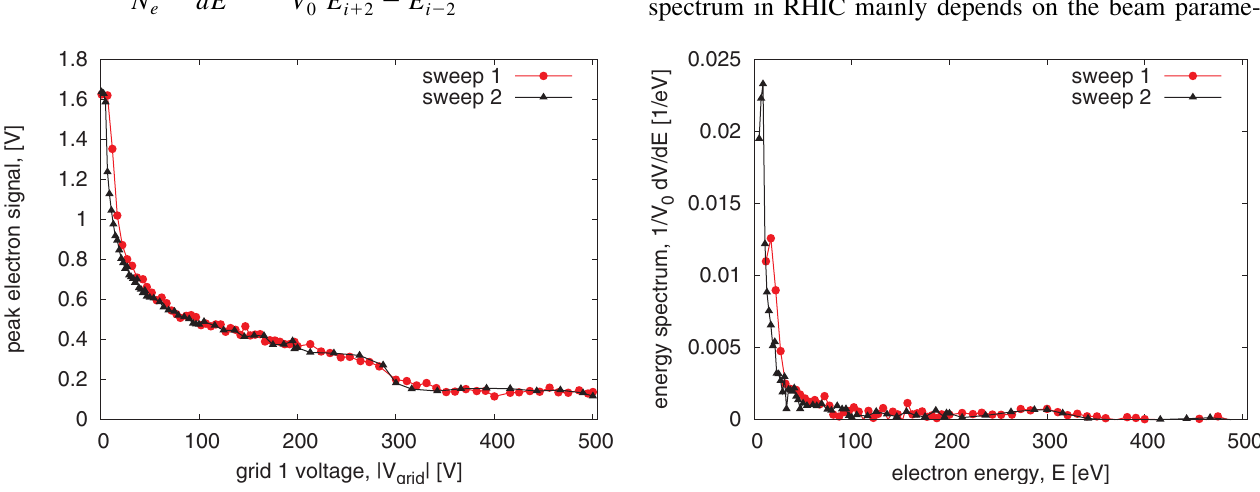
FIG. 12. (Color) Two measured integrated energy spectrum (left-hand side plot), and the derived electron distribution (right-hand side plot) for energies between 0 and 500 eV. The amplitude of the noise oscillations is about 0.15